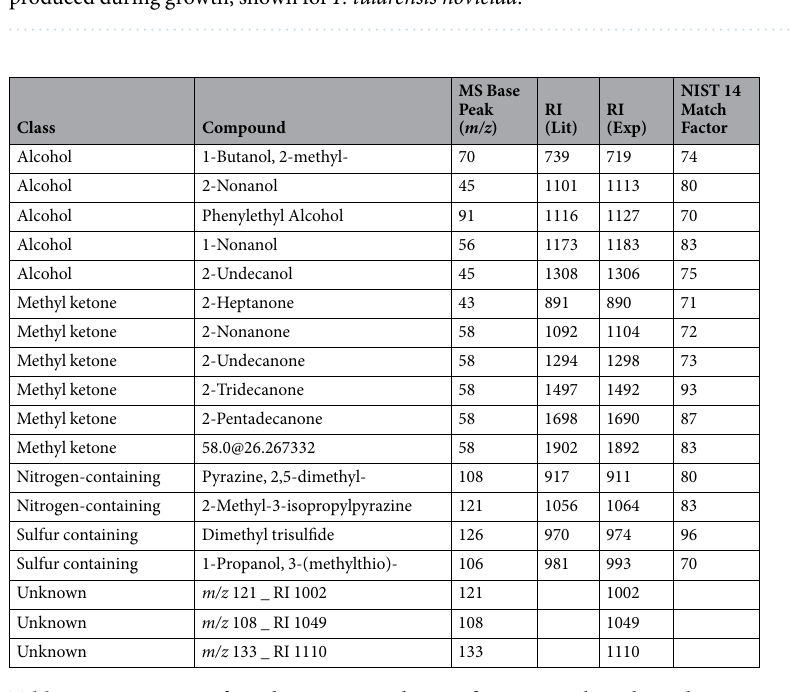
Figure 2. Example workflow of criteria utilized to filter list of detected VOCs to bacteria-specific biomarkers produced during growth, shown for F. tularensis novicida .